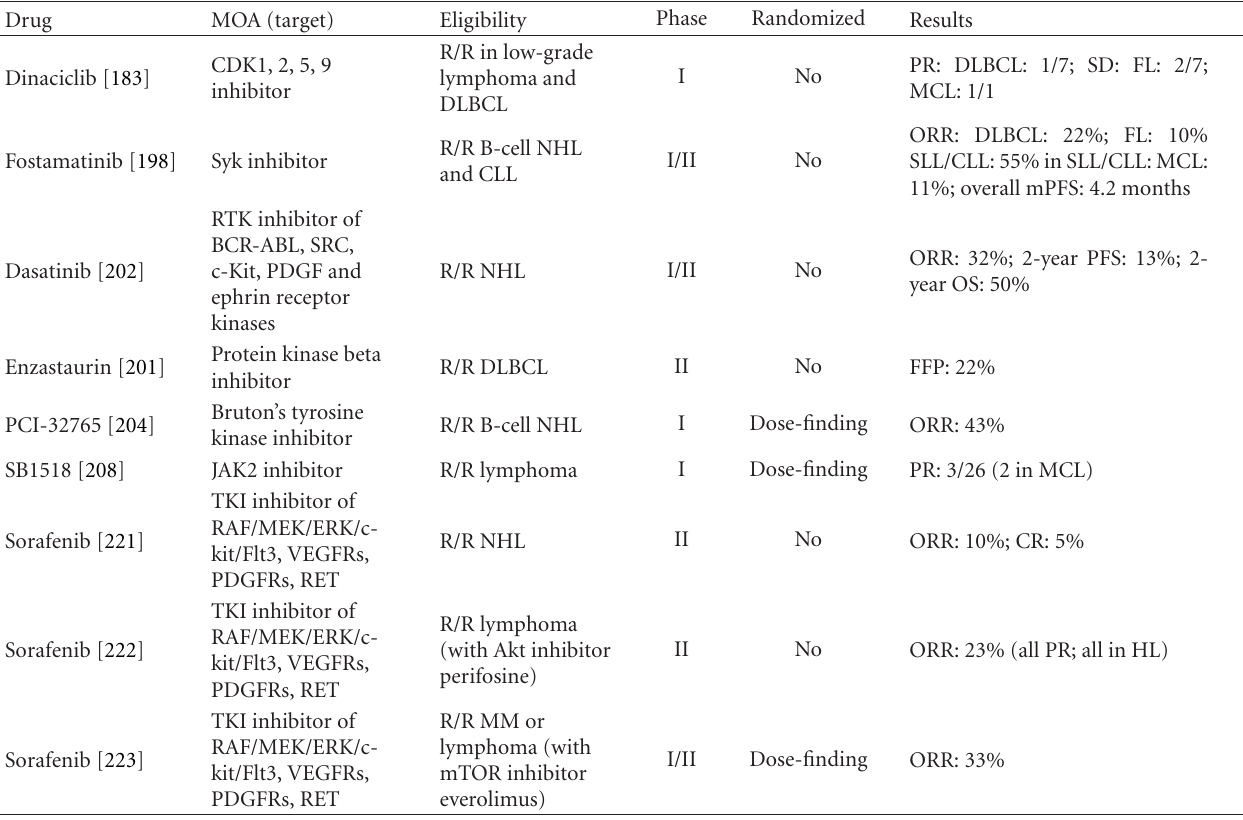
Table 6: Kinase inhibitors currently in clinical development for the treatment of aggressive NHL. [CDK: cyclin-dependant kinase; CLL: chronic lymphocytic leukemia; CR: complete response; DLBCL: di ff use large B-cell lymphoma; ERK: extracellular signal regulated kinase; FFP: freedom from progression; FL: follicular lymphoma; HL: Hodgkin lymphoma; JAK: Janus kinase; MCL: mantle cell lymphoma; mPFS: median progression-free survival; NHL: non-Hodgkin lymphoma; MEK: mitogen-activated protein kinase kinase; MM: multiple myeloma; mTOR: mammalian target of rapamycin; ORR: overall response rate; OS: overall survival; PDGF: platelet-derived growth factor; PDGFR: platelet-derived growth factor receptor; PFS: progression-free survival; PR: partial response; R/R: relapsed or refractory; RTK: receptor tyrosine kinase; SD: stable disease; SLL: small lymphocytic lymphoma; TKI: tyrosine kinase inhibitor; VEGFR: vascular endothelial growth factor